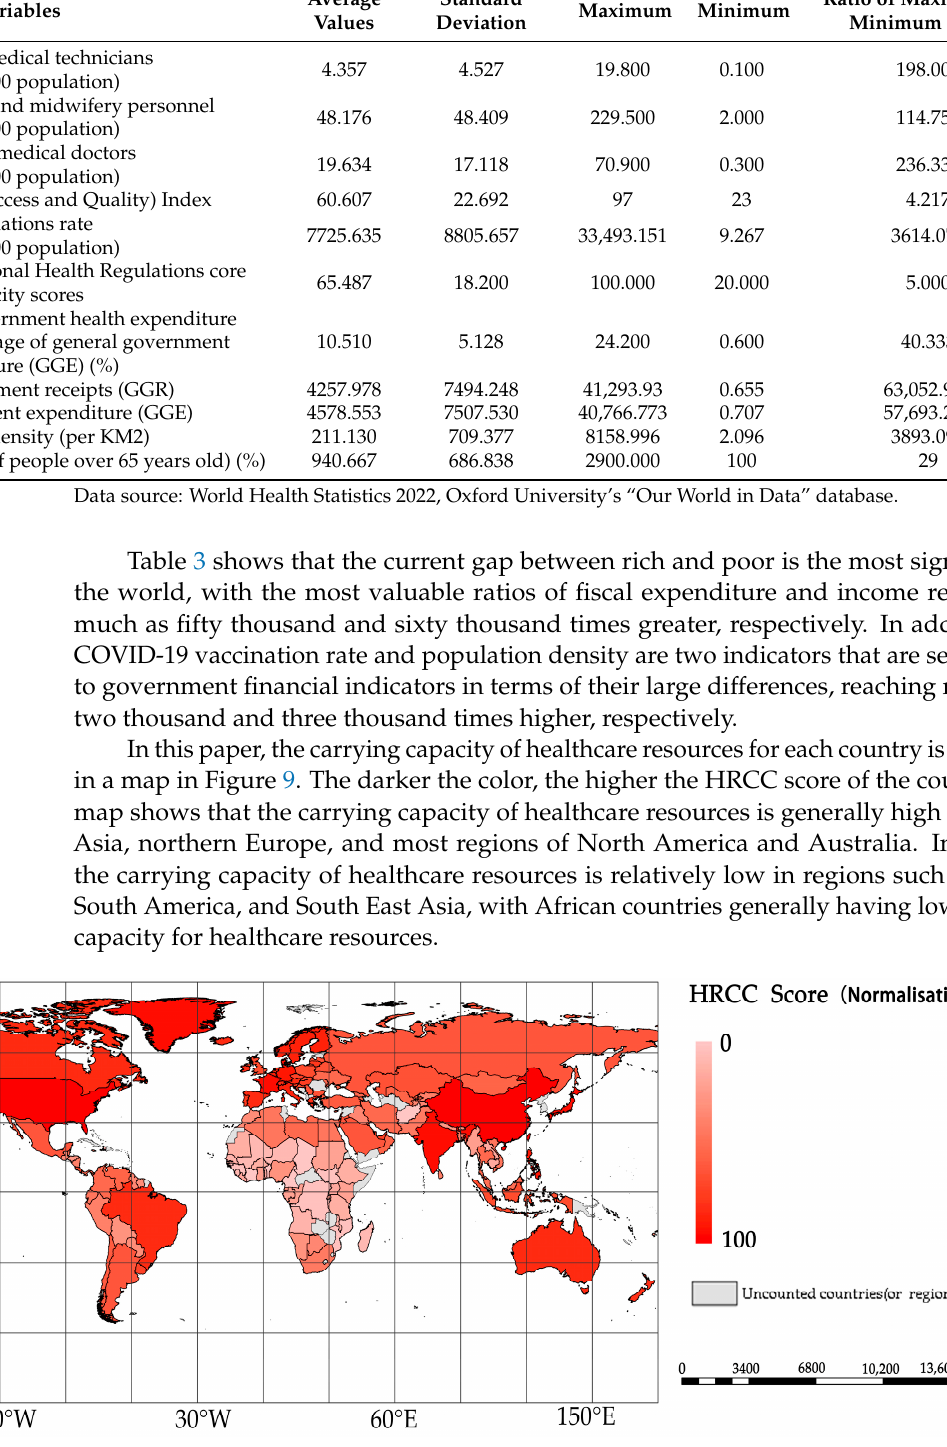
Figure 9. HRCC scores for 150 countries.